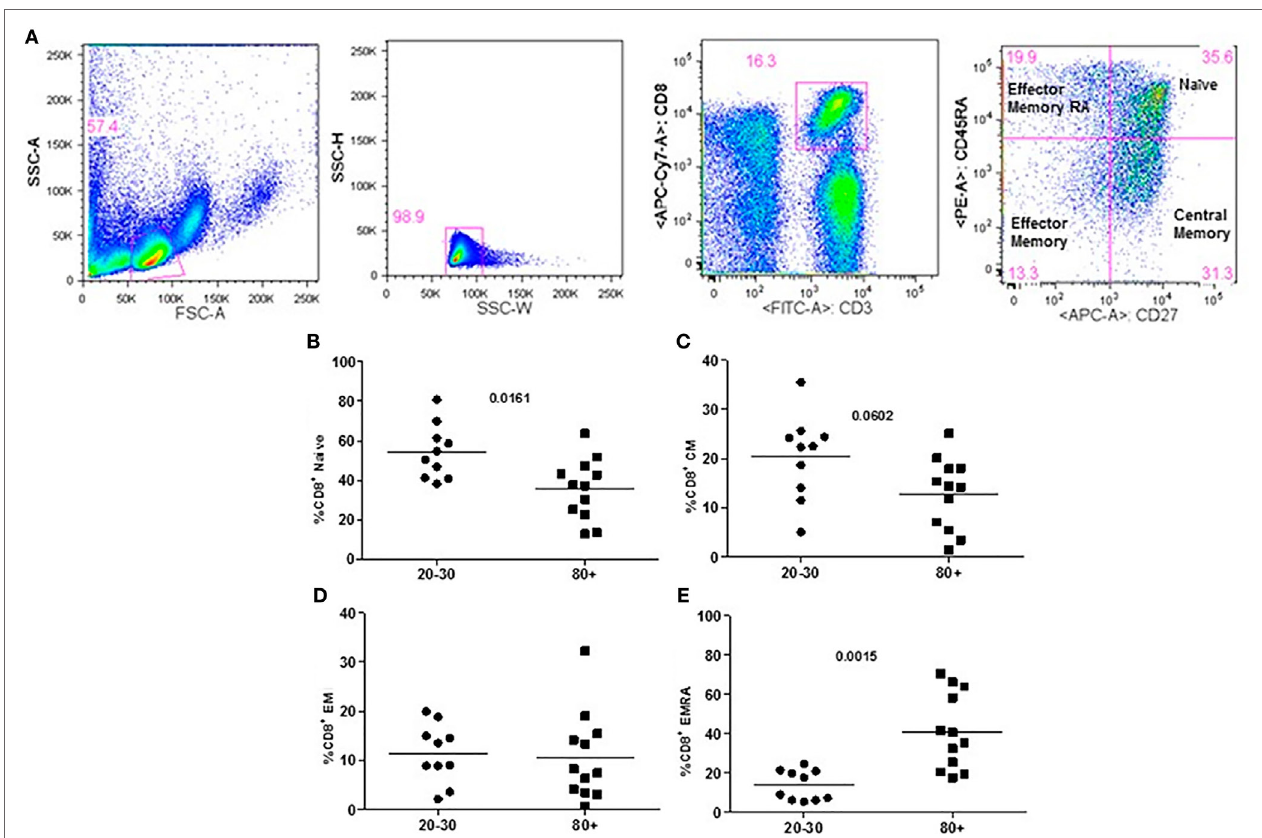
FigUre 4 | Representative flow cytometry plots showing gate strategy for the frequency of CD8 + T cells phenotype. Gate in live lymphocytes (FSC-A × SSC-A), doublets exclusion (SSC-H × SSC-W), gate in CD3 + CD8 + T cells, gate in CD45RA + CD27 + (Naïve) T cells, gate in CD45RA − CD27 + (central memory) T cells, gate in CD45RA − CD27 − (effector memory), gate in CD45RA + CD27 − (effector memory re-expressing CD45RA) T cells (a) . Percentage (%) of CD8 + T cells phenotypes: Naïve (b) , central memory (c) , effector memory (D) , effector memory RA re-expressing CD45RA (e) in 20–30 and 80 + years old